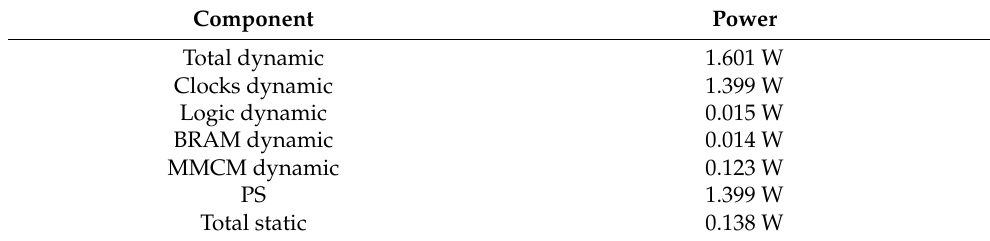
Table 5. The power of the TDC system.